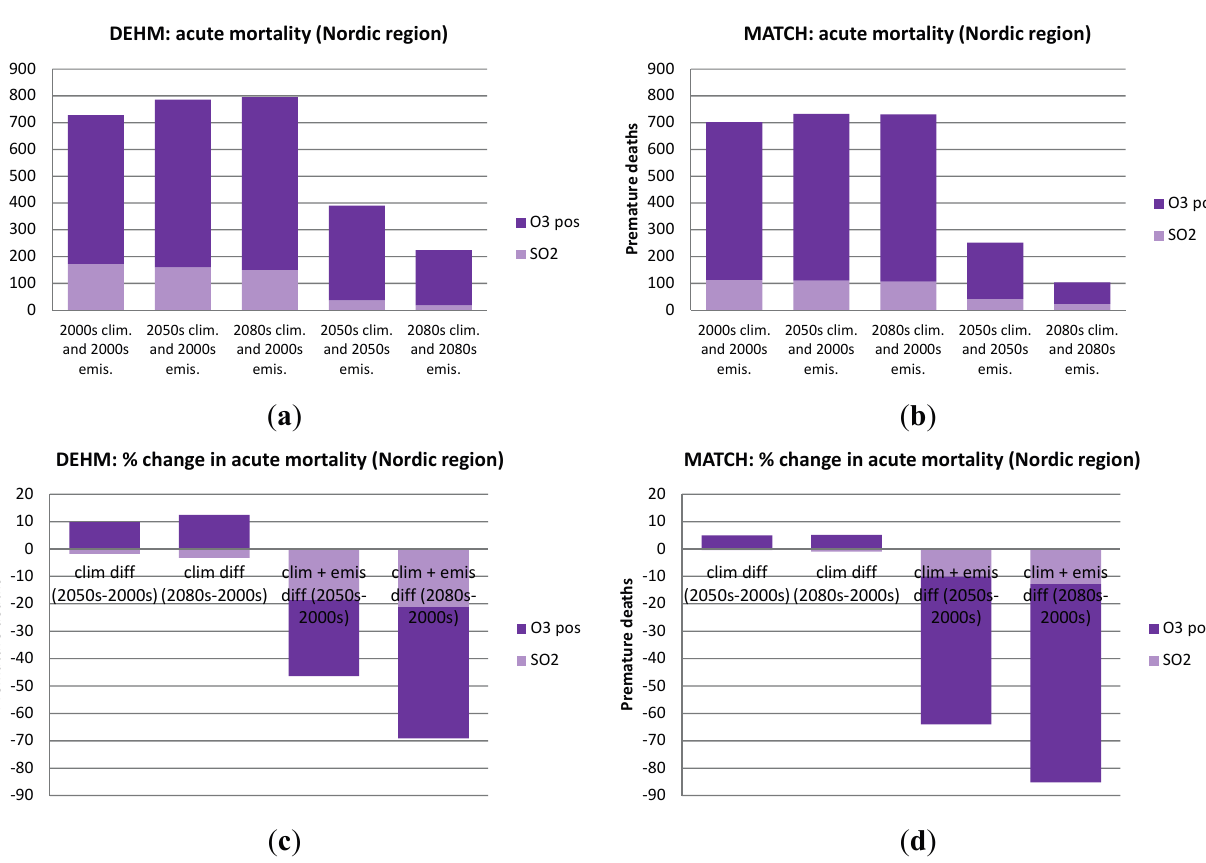
Figure 5. Chronic mortality as estimated by DEHM (left) and MATCH (right) for the European region. In ( a ) and ( b ) the first three columns show the number of premature deaths in the 2000s, the 2050s and 2080s, when only changing the climate. The last two columns includes both climate and emissions changes for the 2050s and the 2080s; In ( c ) and ( d ) the change in % relative to the 2000s are displayed. The impact of the different PM components is also indicated. Note that “SO 4 ” here includes the full weight of SO 42 − , H 2 SO 4 , NH 4 SO 4 and (NH 4 ) 2 SO 4 , while “NO 3 ” includes the full weight of NO 3 − and NH 4 NO 3 . “primary PM 2.5 ” refers to the mass related to primary emitted BC and OC.